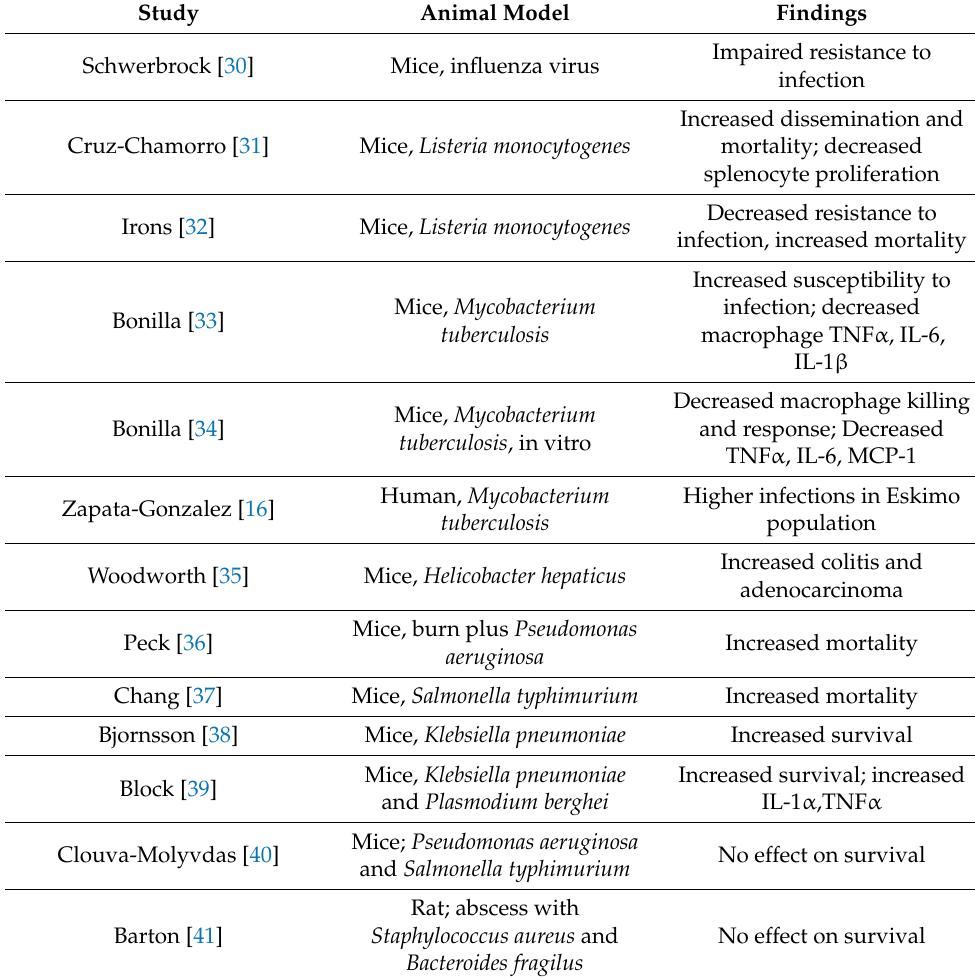
Table 2. Effect of n -3 PUFA supplementation on infection in animal